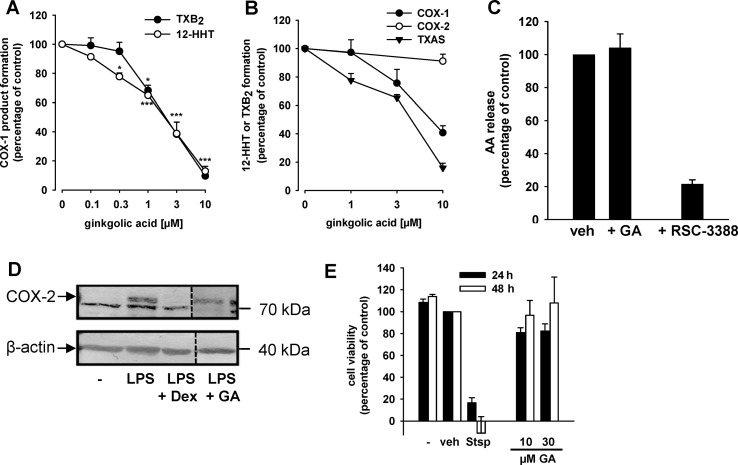
GA inhibits COX-1 and TXAS activities without affecting COX-2, cPLA2, and cell viability. (A) GA inhibits COX-1-dependent TXB2 and 12-HHT formation in human platelets. Platelets (108/ml PBS pH 7.4 containing 1 mM CaCl2) were pre-incubated with GA or vehicle (0.3% DMSO) for 5 min prior to stimulation with AA (5 µM). After another 5 min at 37°C, 12-HHT was determined by RP-HPLC and TXB2 using a TXB2 High Sensitivity EIA Kit. Data are means + S.E., n = 3, *p < 0.05, ***p < 0.001 vs. vehicle (DMSO) control (=100%), ANOVA + Tukey HSD post hoc tests. (B) Purified ovine COX-1 (50 units) or human recombinant COX-2 (20 units) were pre-incubated with GA for 5 min prior to stimulation with AA (5 µM or 2 µM, respectively). After 10 min, 12-HHT formation was analyzed using RP-HPLC. TXAS activity was determined in platelet homogenates (108/ml PBS containing 1 mM CaCl2, sonified 3 × 15 s) pre-incubated for 15 min with GA on ice and stimulated with 20 µM PGH2 for 1 min. TXB2 levels were assessed using a TXB2 High Sensitivity EIA Kit. Data are means + S.E., n = 3–4, **p < 0.01, ***p < 0.001 vs. vehicle (DMSO) control, ANOVA + Tukey HSD post hoc tests. (C) Effects of GA (10 µM) and RSC-3388 (1 µM) on cPLA2 in a cell-free assay. Freshly prepared large unilamellar vesicles were incubated with cPLA2 enzyme, 1 mM Ca2+, and the indicated compounds for 1 h at 37°C. After derivatization with p-anisidinium chloride, the resulting derivate was analyzed by RP-HPLC. Data are means + S.E., n = 3, ***p < 0.001 vs. vehicle (DMSO) control, ANOVA + Tukey HSD post hoc tests. (D) Expression of COX-2 protein. Human monocytes were preincubated with GA (10 µM), dexamethasone (1 µM), or vehicle (0.1% DMSO), and then stimulated with 1 µg/ml lipopolysaccharide (LPS) for 24 h at 37°C. Cells were detached and lysed. Samples were subjected to SDS-PAGE and Western blot using a specific antibody against COX-2 (upper band, indicated by arrow); β-actin was used as loading control. Results are representative of three independent experiments. (E) Cytotoxicity in A549 cells. Cells were incubated for 24 h and 48 h at 37°C with GA, staurosporine (Stsp, 3 µM), or vehicle (0.1% DMSO). Then, MTT was added and samples were incubated for 4 h at 37°C. The reaction was stopped and the absorption was measured at 570 nm. Cell viability is reported as percentage of vehicle control. Means + S.E. of n = 3.